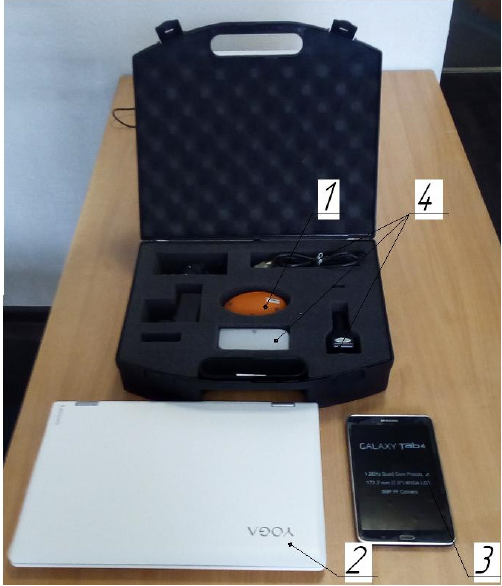
Figure 3. General view of the software tool “Electronic Tuber Log”: 1 — data logger; 2 — personal computer; 3 — tablet computer; 4 — auxiliary devices.